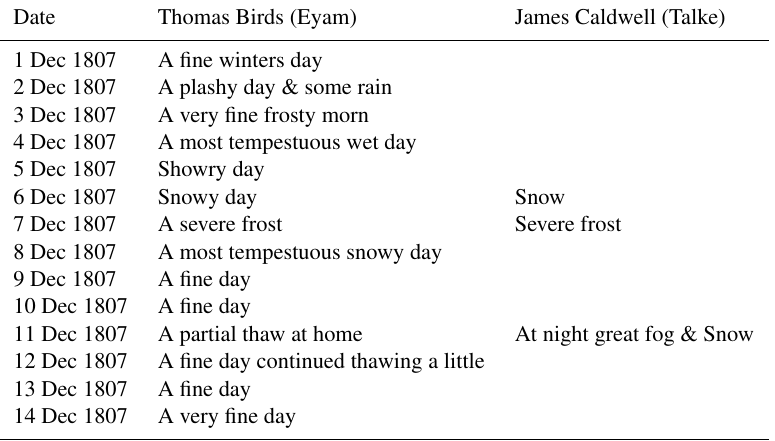
Table 1. Diary entries for Thomas Birds and James Caldwell, December